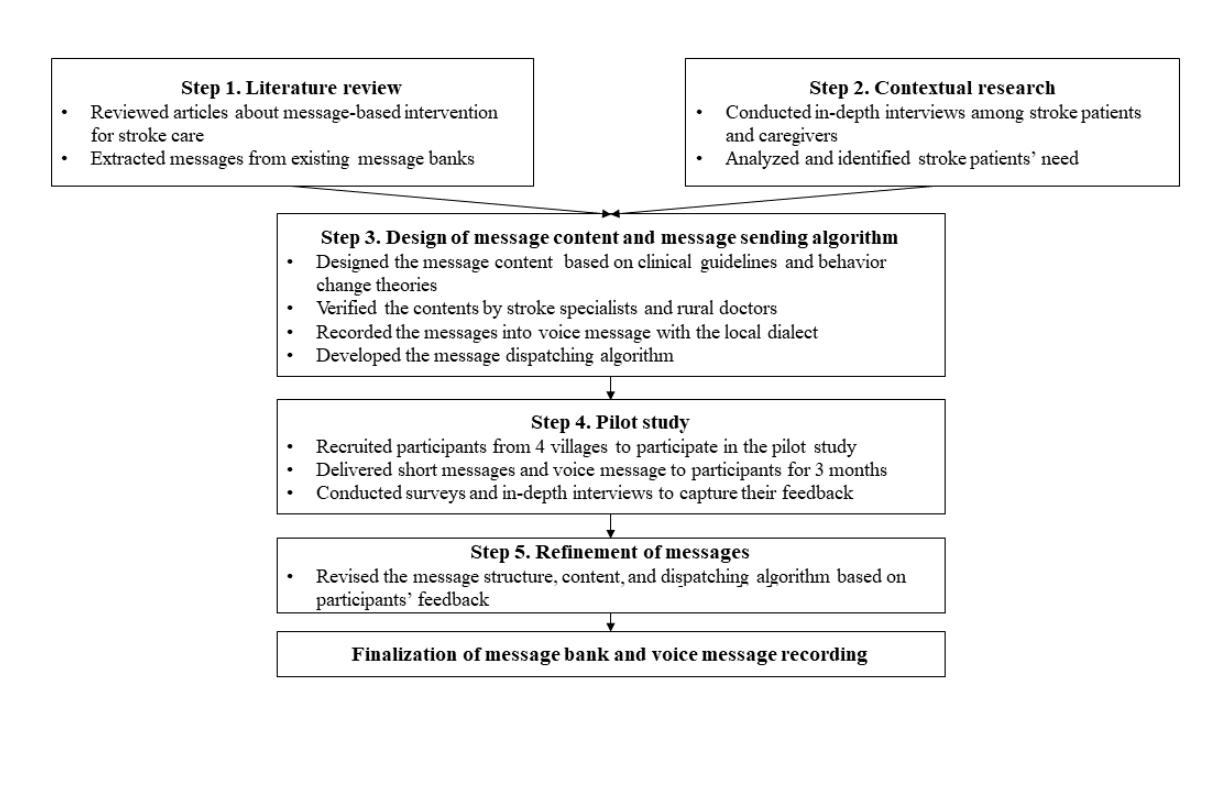
Figure 1. Overview of key stages of message